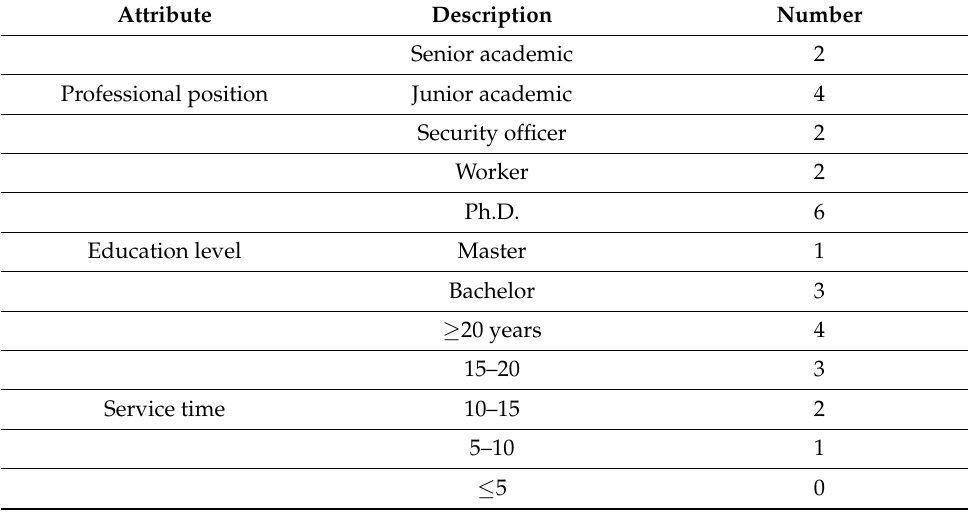
Table 1. Information of a group of experts.